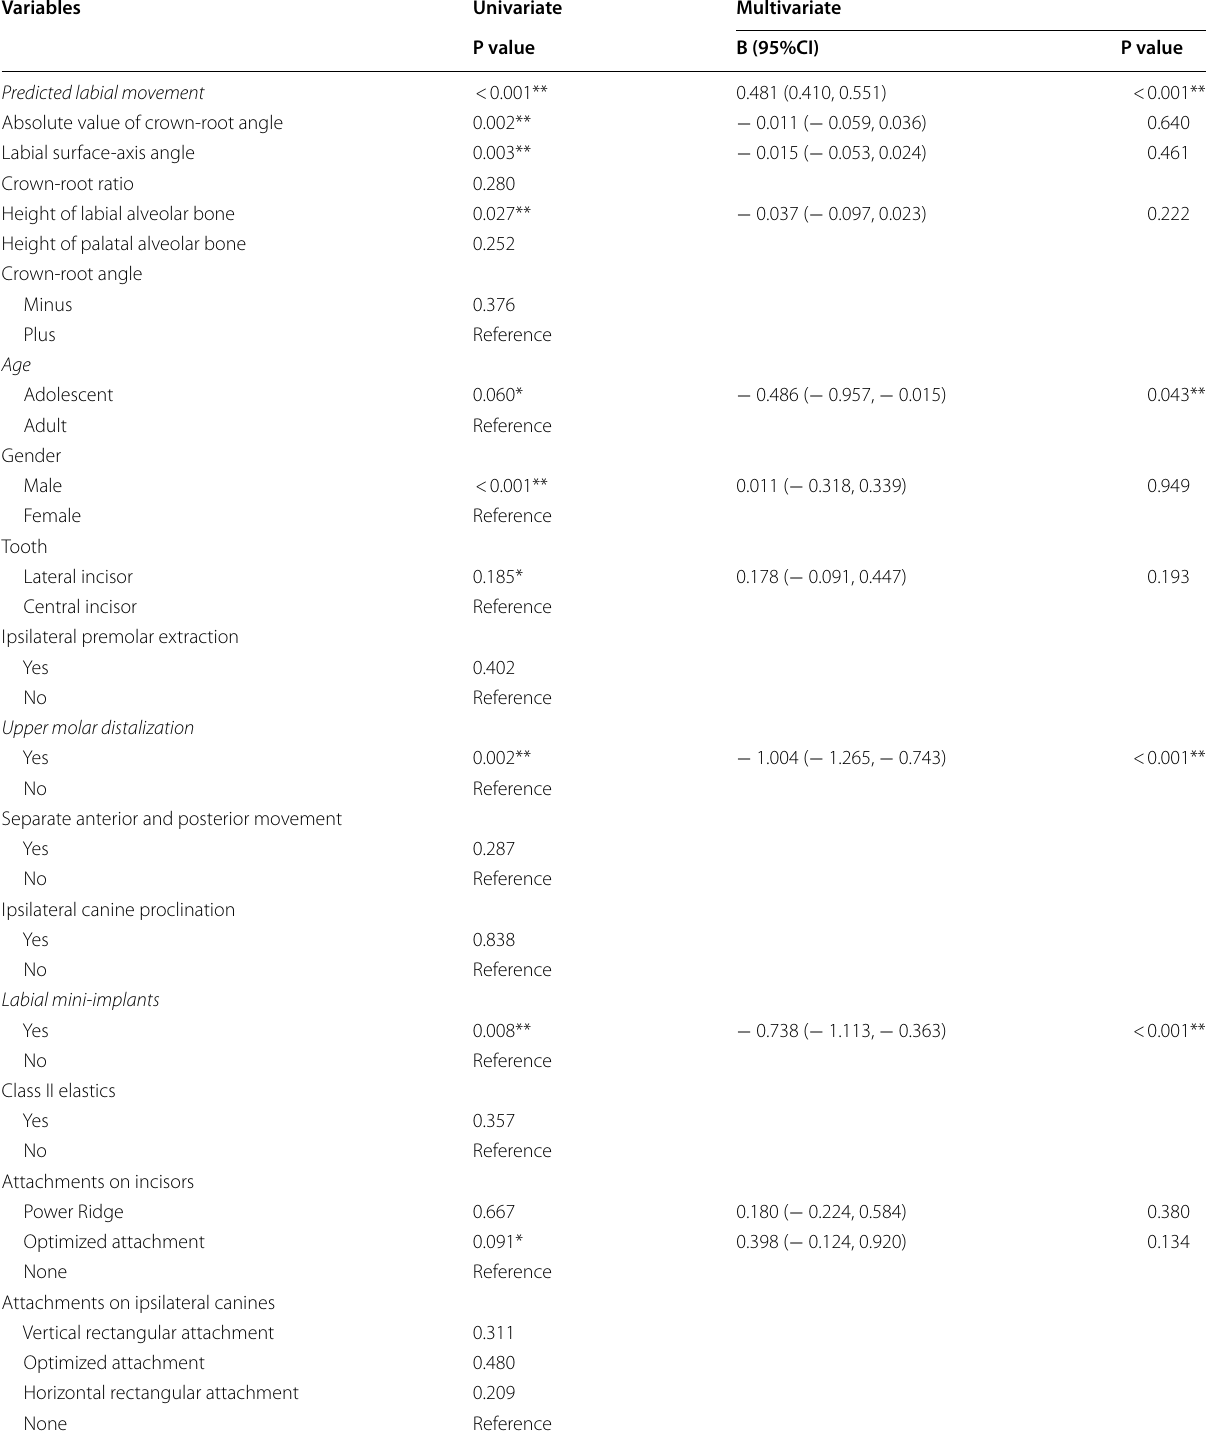
Table 7 Univariate and multivariate linear regression analyses for DPA of upper incisor labial